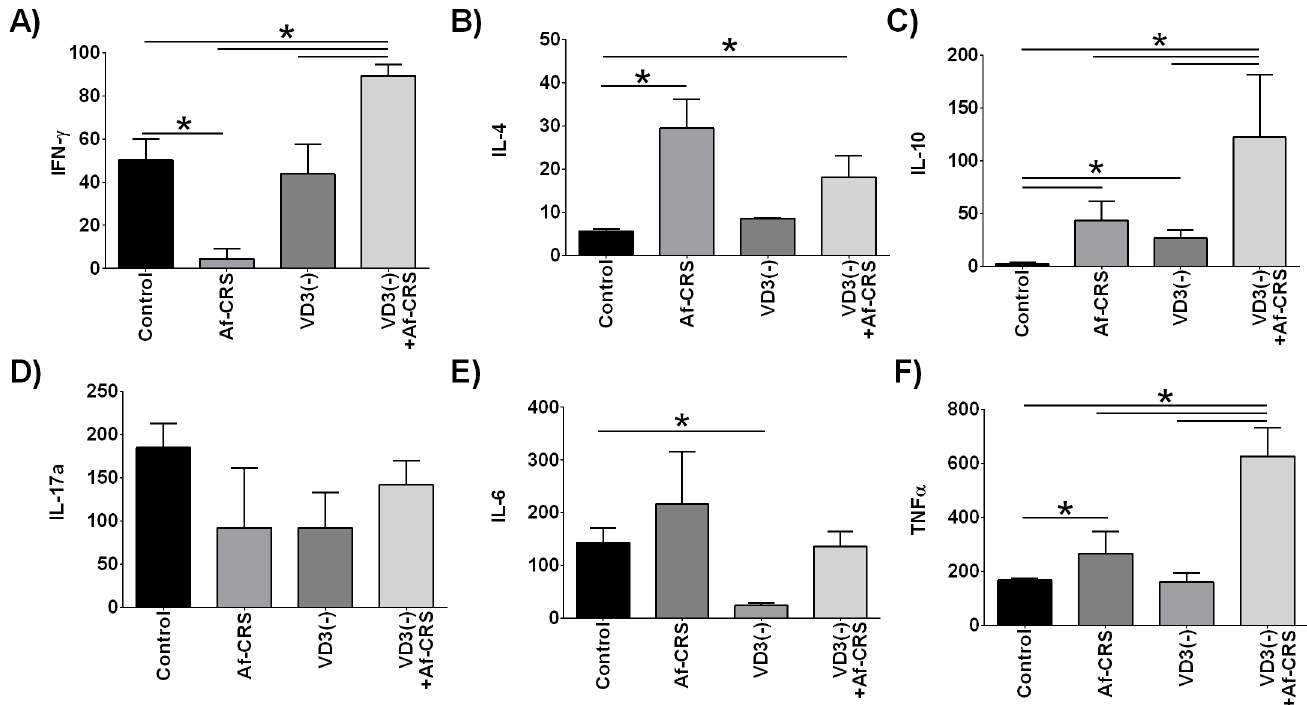
Fig 9. VD3 deficiency selectively exacerbates nasal lavage type 1, type 2 and pro-inflammatory cytokines. NALF cytokines were measuredby cytometric bead array. All values shownare in pg/ml. * p < 0.05betweenindicatedgroups. n = 3–4 mice per group.